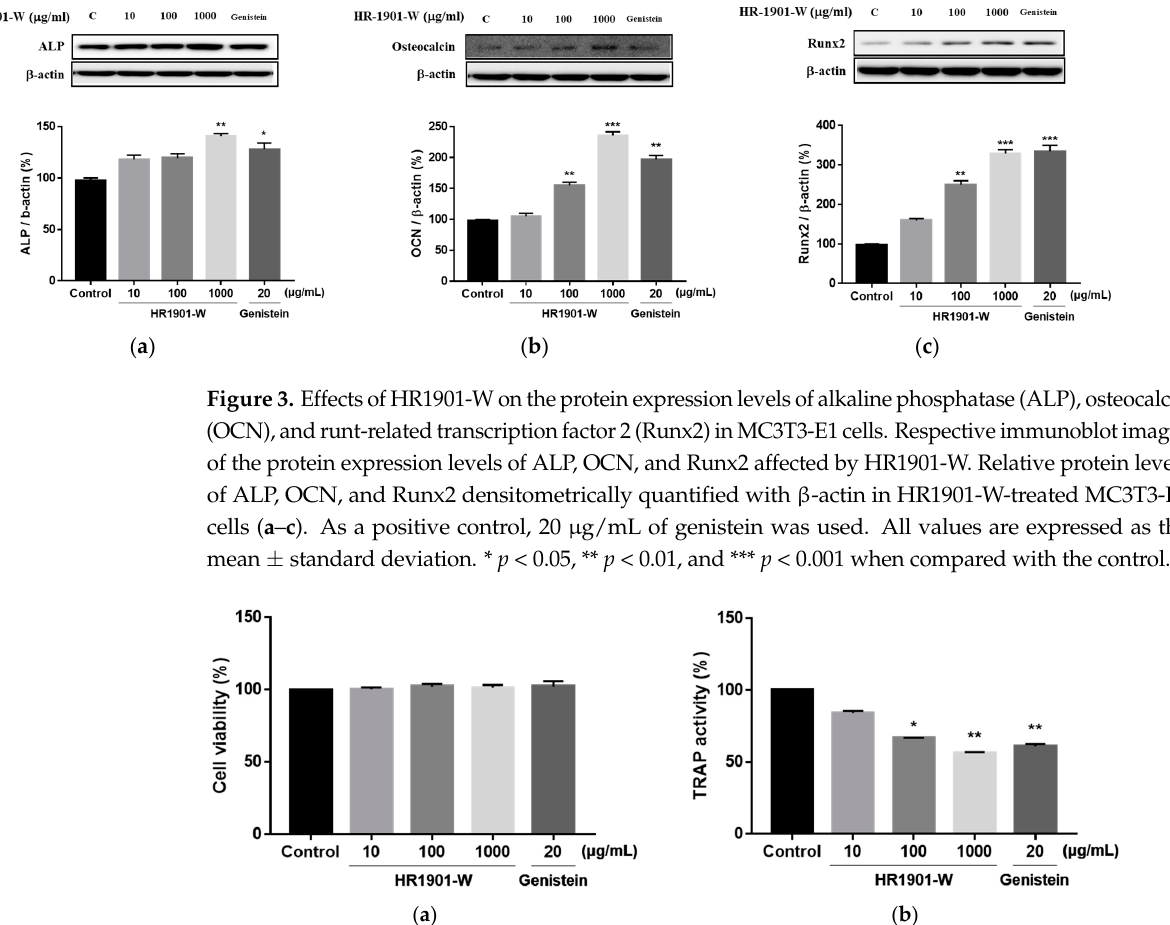
Figure 4. Effect of HR1901-W on the cell viability ( a ) and tartrate-resistant acid phosphatase (TRAP) activity ( b ) of RAW 264.7 cells. All values are expressed as the mean ± standard deviation. * p < 0.05 and ** p < 0.01 when compared with the control.